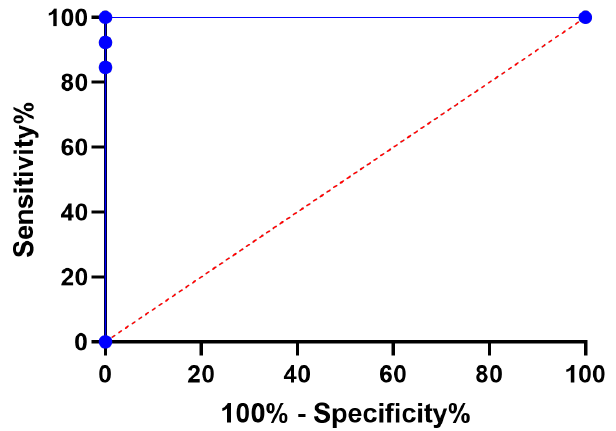
Figure 19. ROC curve of the proposed BO-CNN model vs. ResNet-50 model for the IDRiD